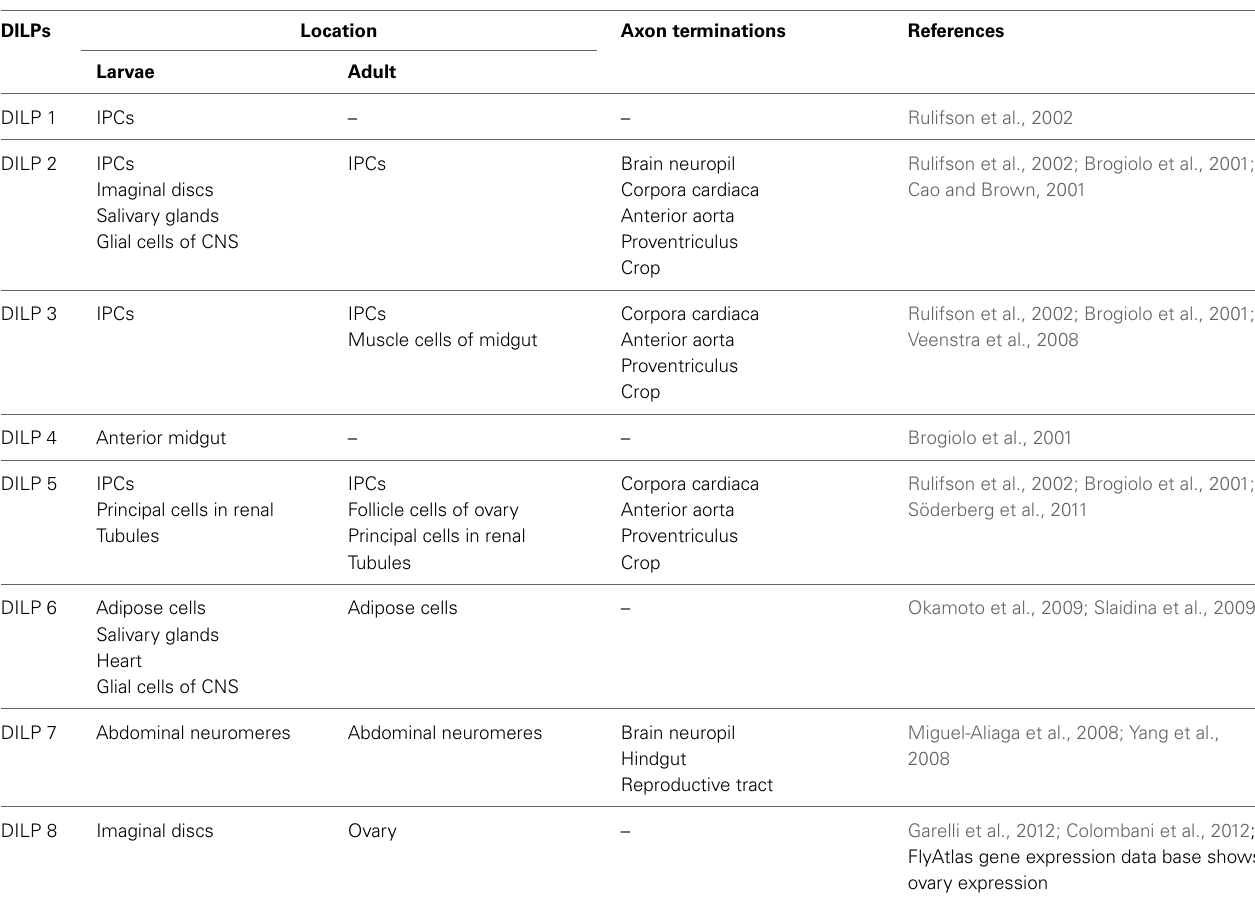
Table 1 | Location of insulin-producing cells in Drosophila